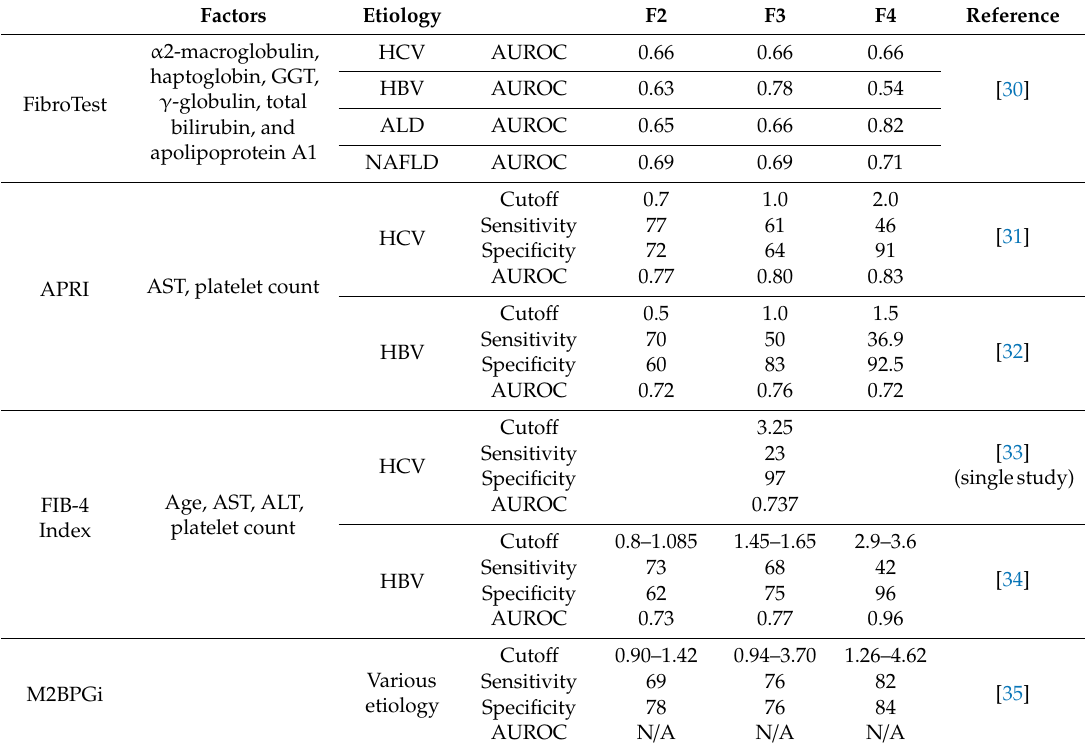
Table 3. Serum tests and their diagnostic